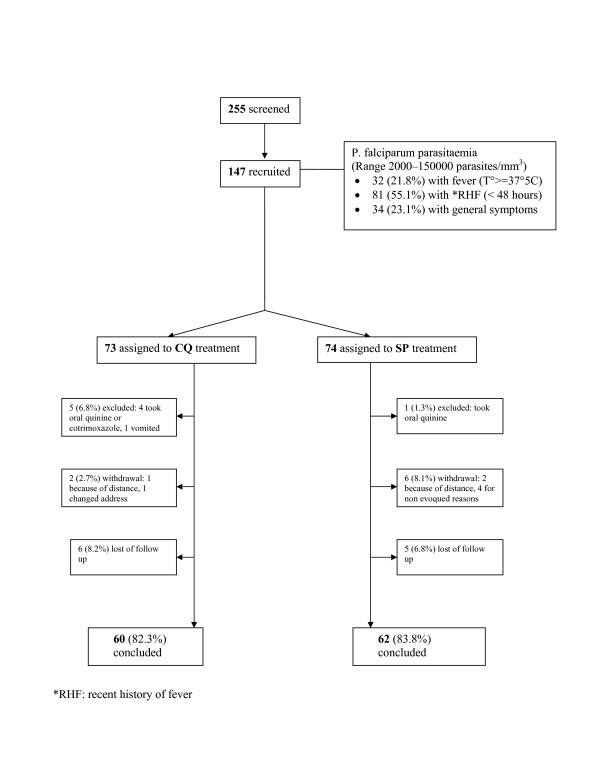
Trial profile. (*RHF: recent history of fever)